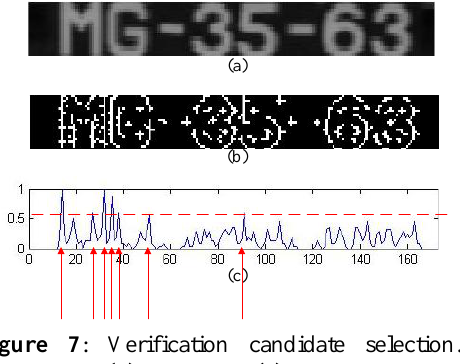
Figure 7 : Verification candidate selection. (a) Extracted plate. (b) Edge map. (c) Candidates.